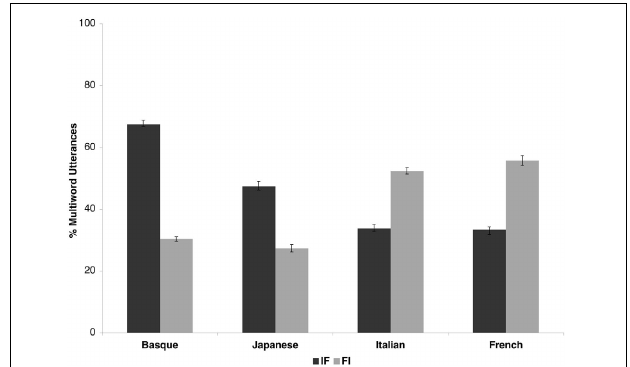
FIGURE 1 | The results of the corpus study. The x-axis shows the four languages. The y-axis represents the percentage of FI (light gray bars) and IF (dark gray bars) phrases at the boundaries of multiword utterances in the four corpora. Note that the maximum value is 200%, as each utterance contributes two data points (one for the beginning, one for the end). Error bars represent the standard error of the mean.